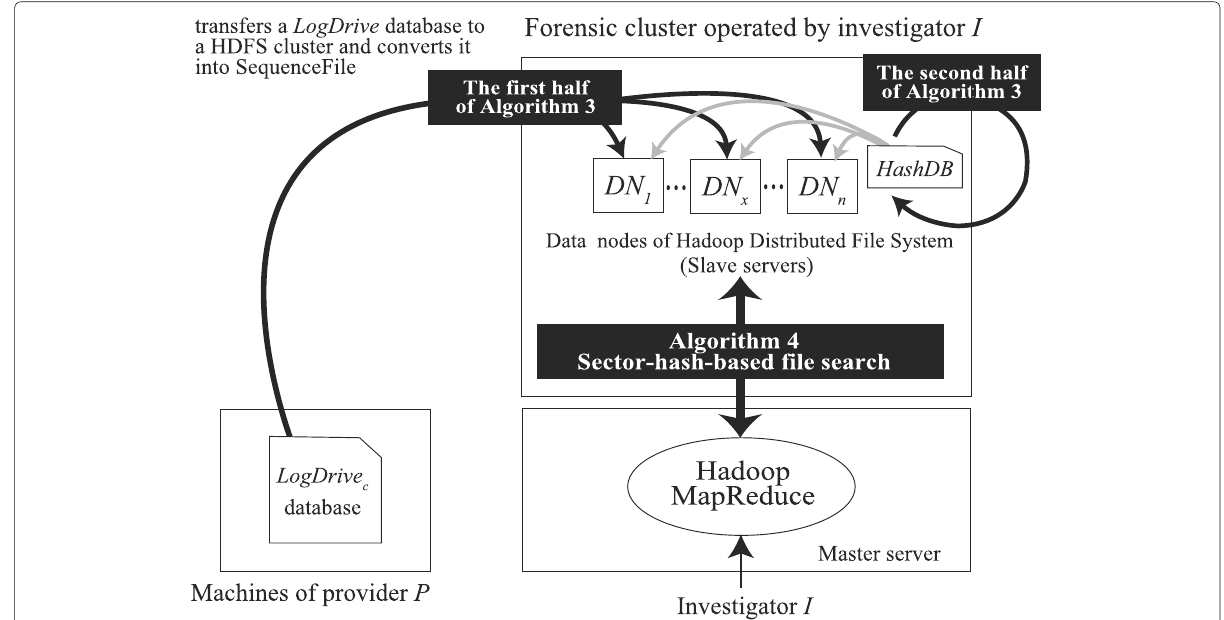
Fig. 7 Implementation of the file search function of the LogDrive